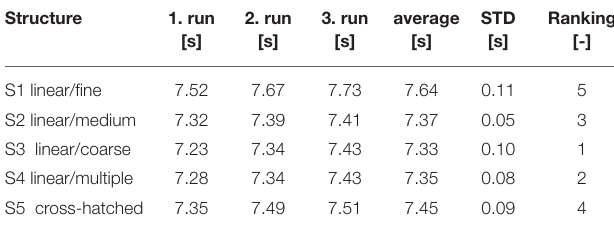
TABLE 3 | Results of sliding test and